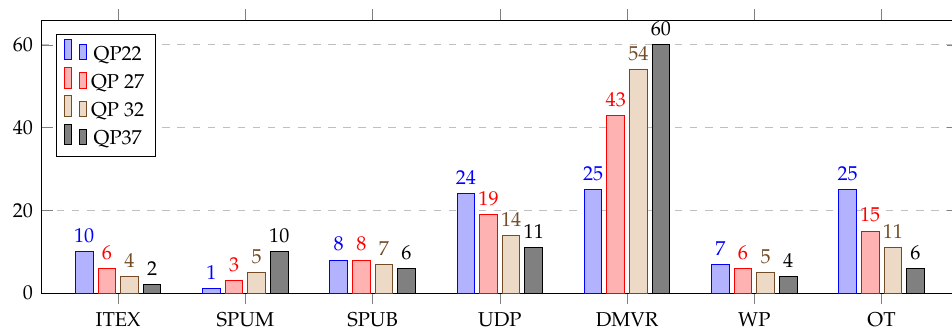
Figure 8. Average time distribution for different parts of the inter prediction (in %) over the EGPP.